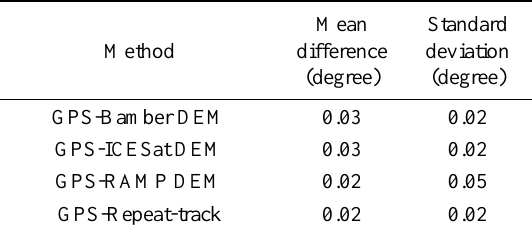
Table 1.Comparison between the slopes derived from GPS data and other